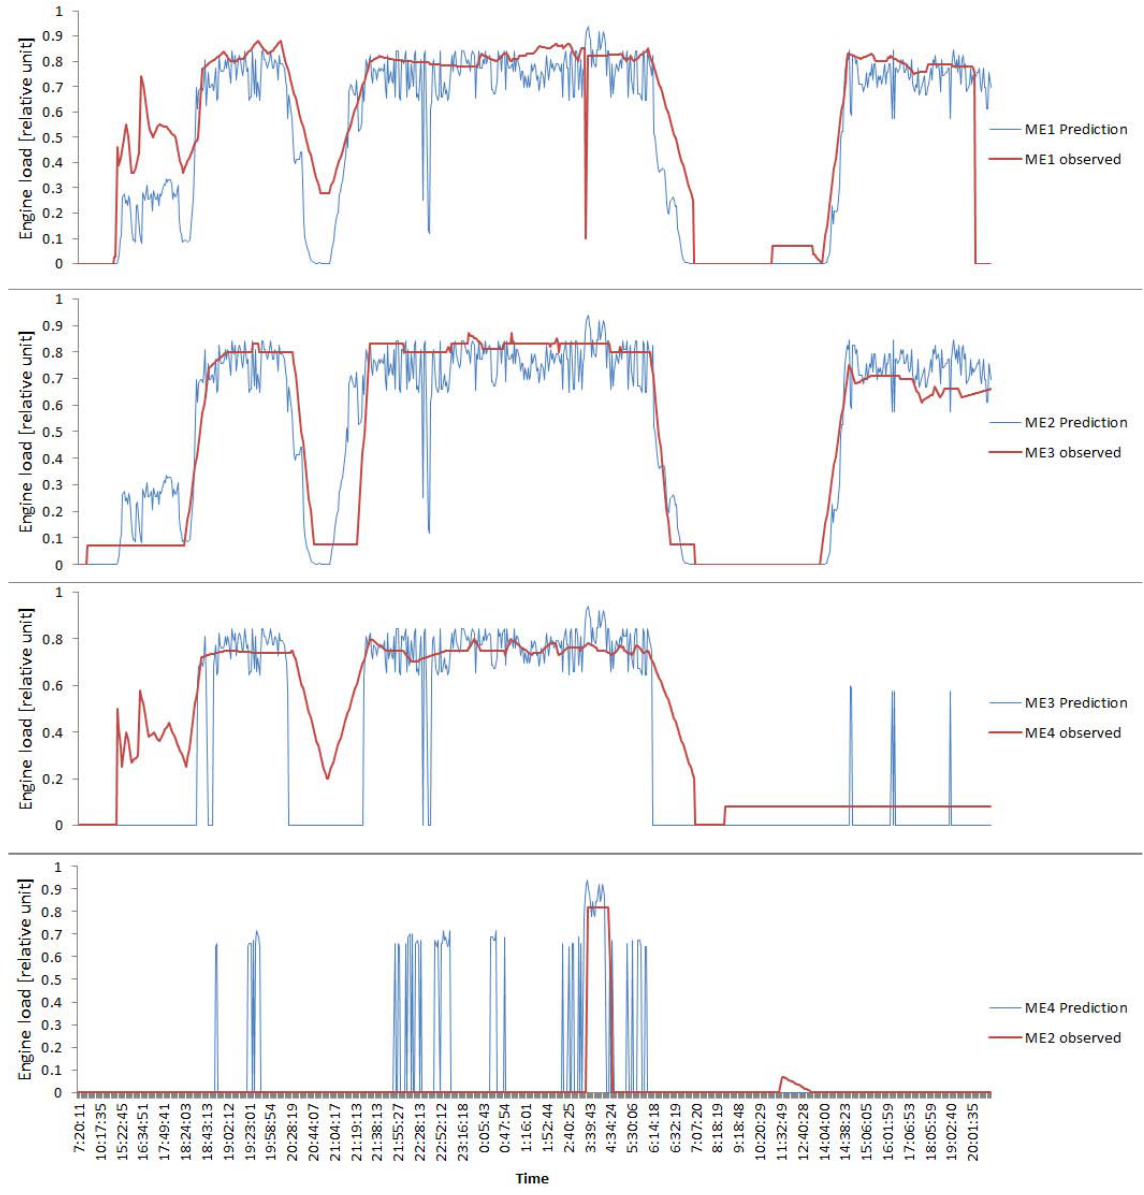
Fig. 10. (a)–(d) : predicted and observed engine loads of four identical main engines in a large RoPax ship. The time scale for all plots (a)–(d) is the same, presented in panel (d) . ME x , x = 1 , 2 , 3 , 4, are the four main engines. “Estimate” refers to the prediction of STEAM2. The numbering of the main engines in the model has no influence on the engine load predictions; for instance, in panel (b) the curves ME2 (estimate) and ME3 (observed) are directly